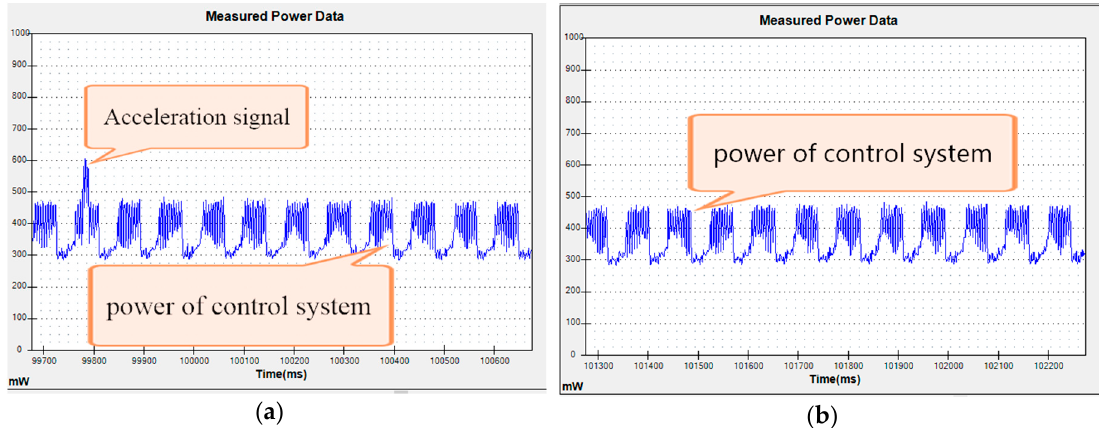
Figure 10. Power of the control system. ( a ) Start process power; ( b ) Smooth running power.